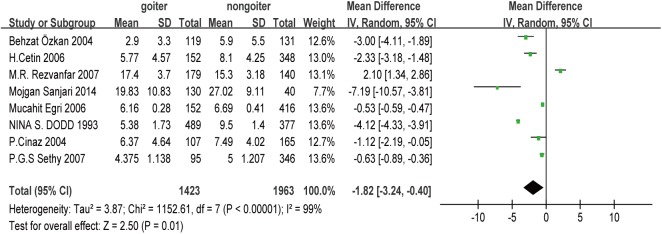
Forest plot showing the comparison of UIC between children with and without goiter.